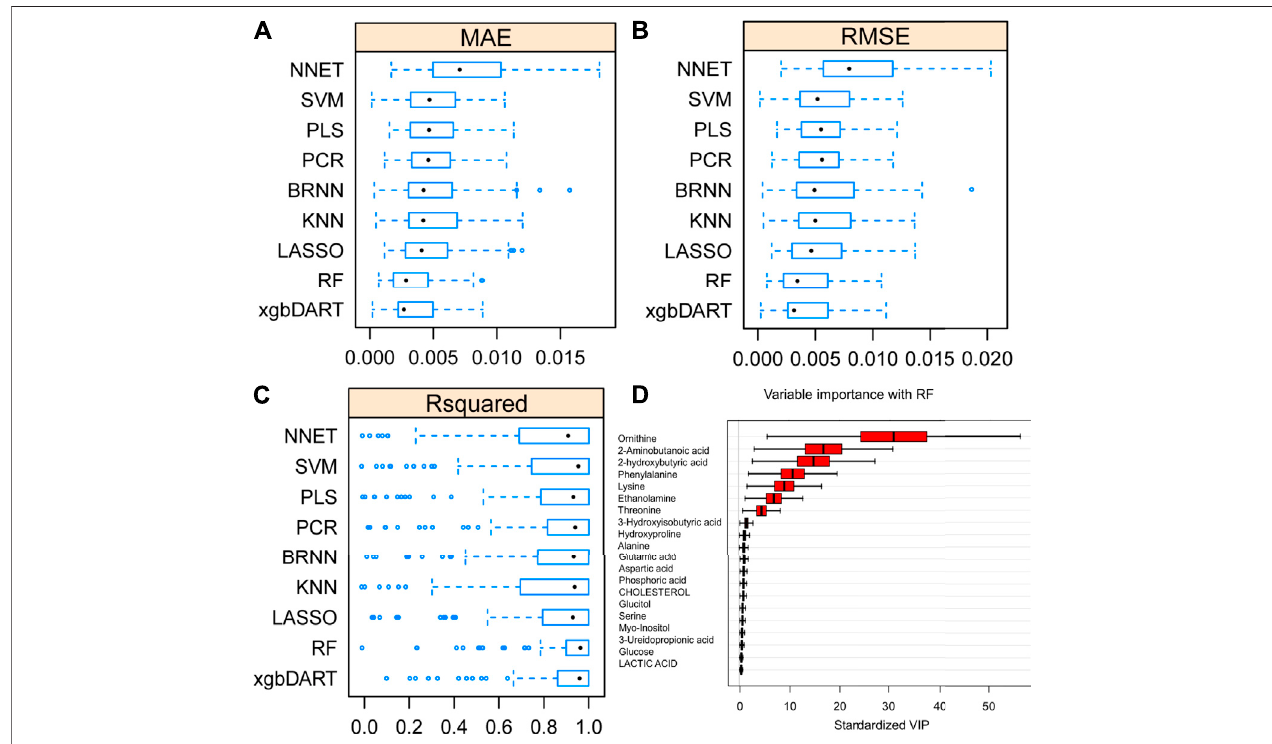
FIGURE3| AverageMAE (A) ,RMSE (B) andR 2 (C) on10repeated10-foldcross-validationofninemachinelearningalgorithmsforpredictionoftheliverindexfrom metabolomics data. (D) Variable importance revealed by random forest (RF) method.